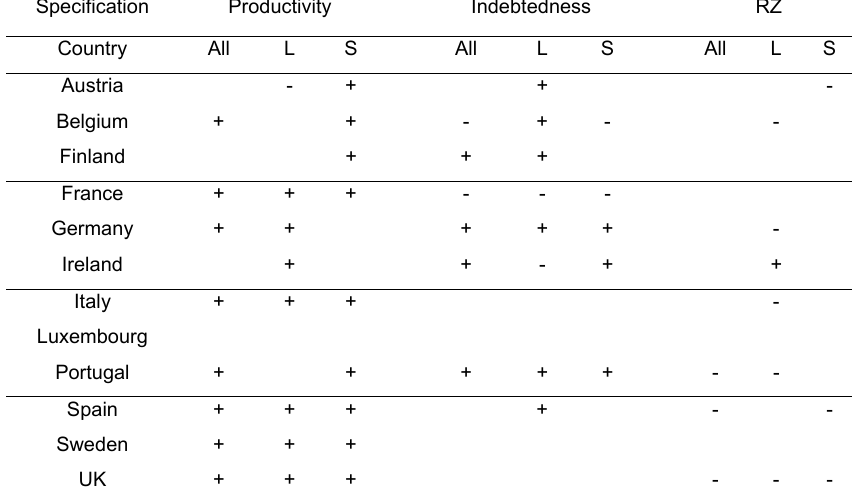
Table 6. Cross-country effects, signs